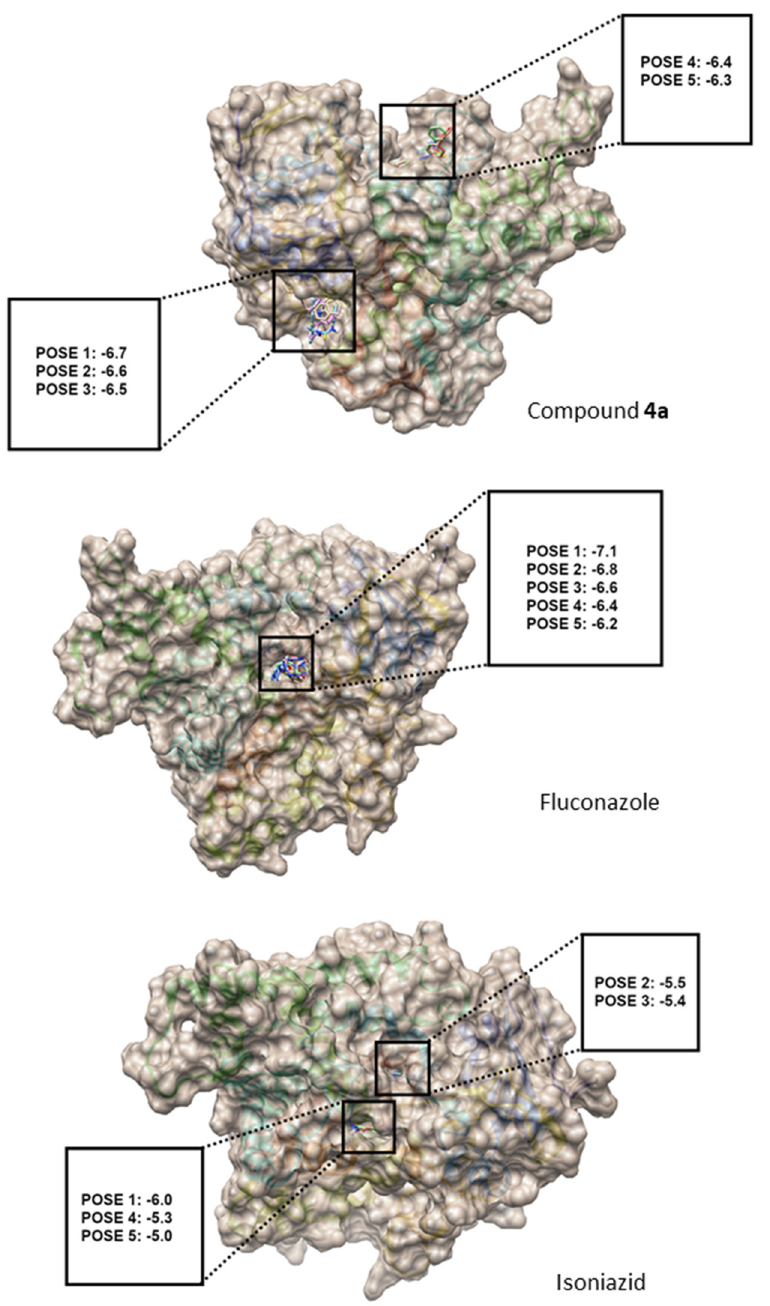
Figure 4. Active sites of CYP51 for binding of compound 4a and controls (Fluconazole & Isonizid).